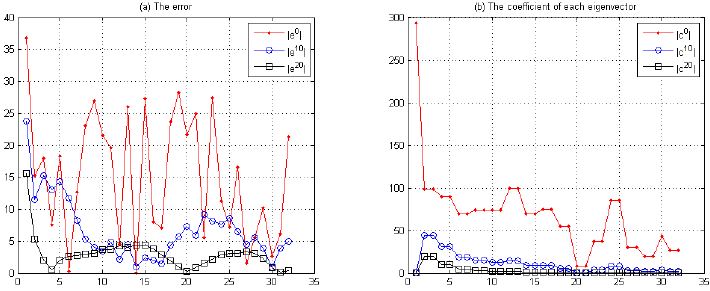
Figure 6. GS: (a) shows the error | e i | = | p − p i | after i GS iterations ( i = 0 , 10 , 20), where p and p i are the exact solution and the iterates, respectively. The error can be expressed as e = (cid:80) c j v j , j = 1 ,..., 32, where v j is the j th eigenvector of the iteration j matrix, with coefficients c